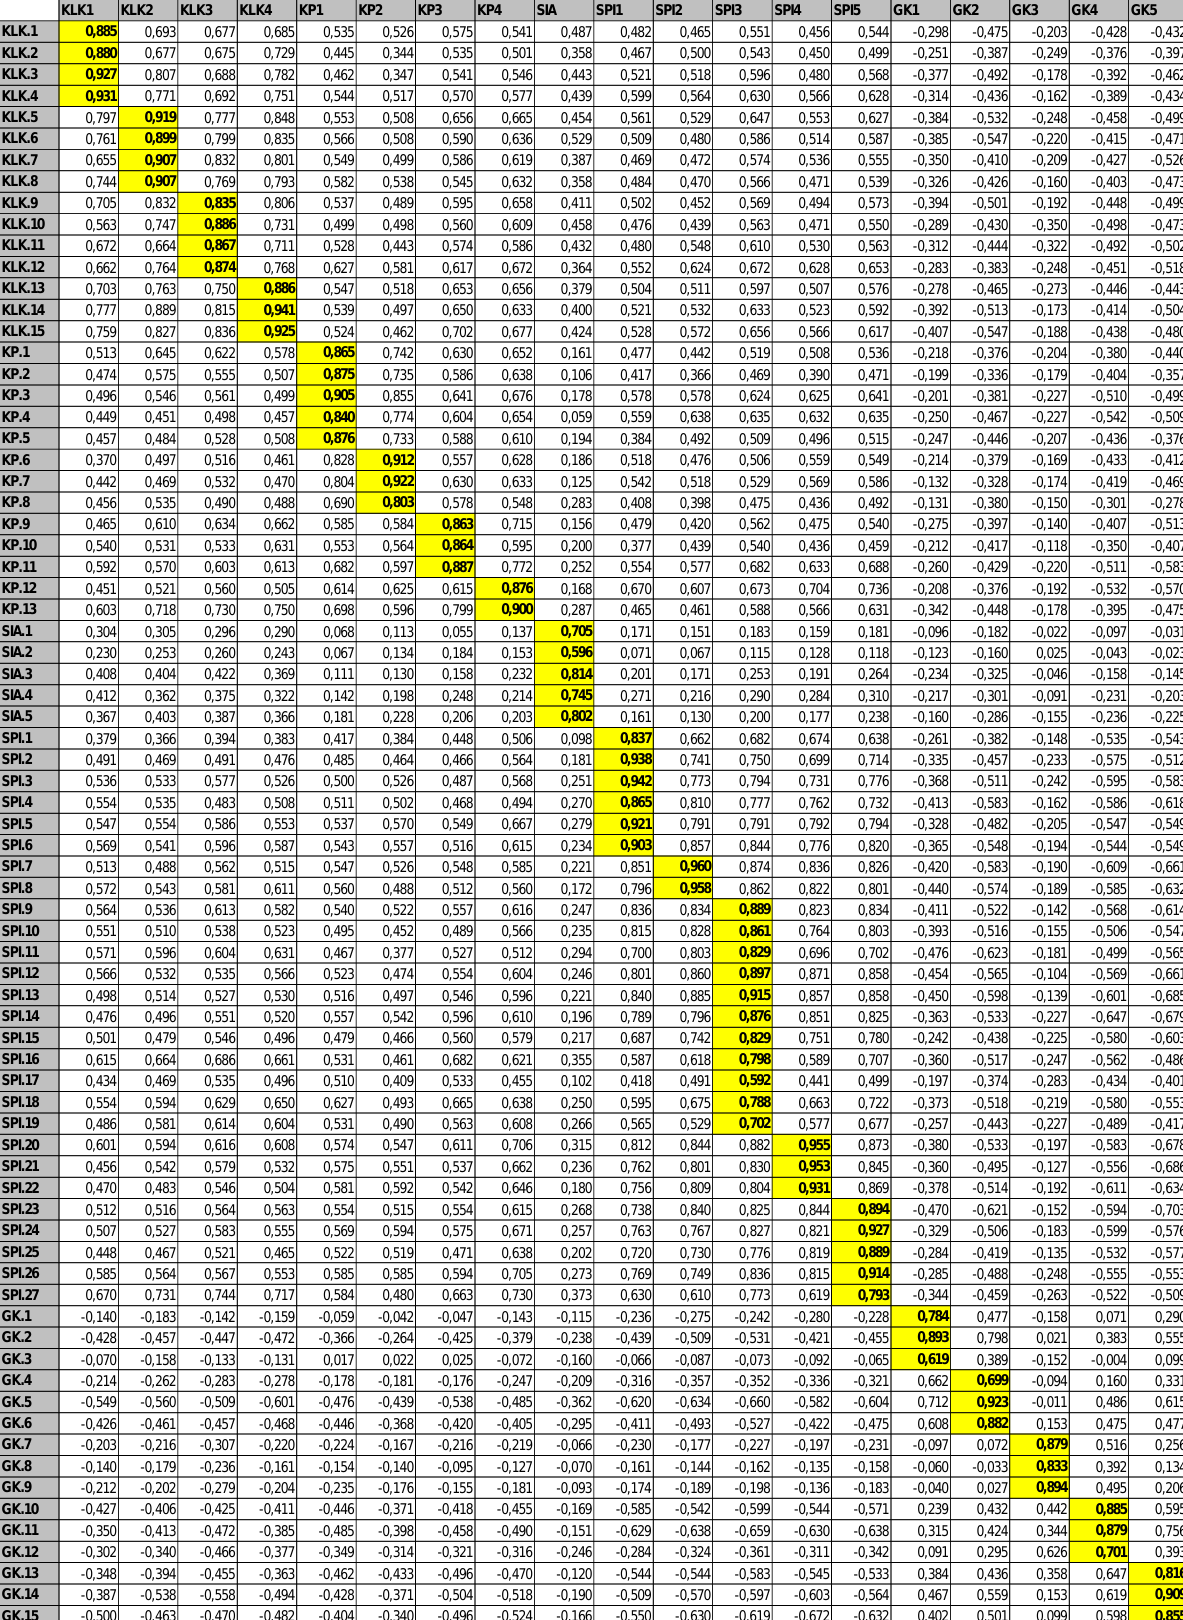
Table 2: Discriminant Validity Test